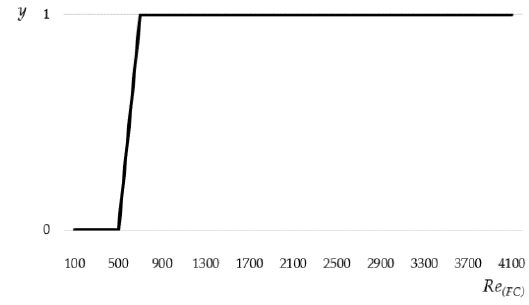
Figure 1. Switching function given in Equation (11).